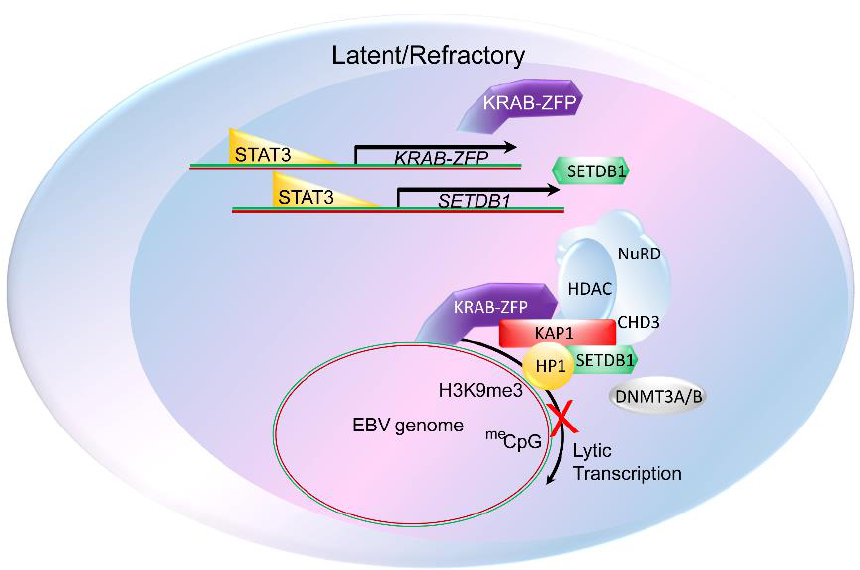
Figure 1. STAT3-mediated regulation of heterochromatin factors and KRAB–KAP1-mediated silencing of the EBV genome in latency. An EBV-infected B cell is illustrated showing the cellular oncoprotein and transcription factor STAT3 transactivating the key heterochromatin regulatory components, including members of the Krüppel-associated box (KRAB) domain–zinc finger protein (ZFP) epigenetic silencing family (KRAB–ZFP), and the histone H3K9me3 methyltransferase, Set Domain Bifurcated 1 (SETDB1). Below, KRAB–ZFPs bind to the EBV genome as well as to KRAB-associated protein 1 (KAP1), which functions as a scaffold for the recruitment of repressive histone-modifying factors SETDB1, heterochromatin amplification factor HP1 that recognizes H3K9me3, the Nucleosome Remodeling and Deacetylase (NuRD) complex, and DNA methyltransferases 3A or 3B (DNMT3A/3B). Histone deacetylase (HDAC) and Chromodomain Helicase DNA Binding Protein 3 (CHD3) are components of the NuRD complex. DNA methylation (meCpG) also results in further suppression of EBV lytic genes during latency and in B cells that are refractory to triggers of the lytic phase. These chromatin modifying events combine to silence lytic gene transcription, keeping EBV latent.